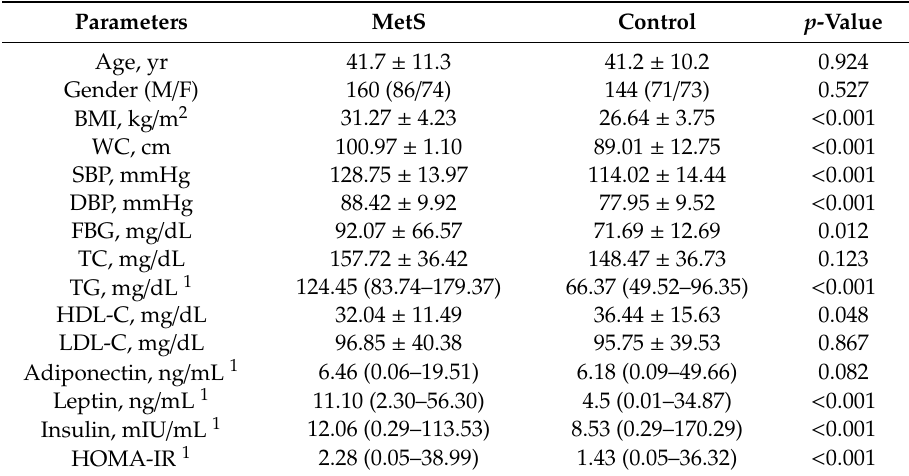
Table 2. Main characteristics of the MetS and control